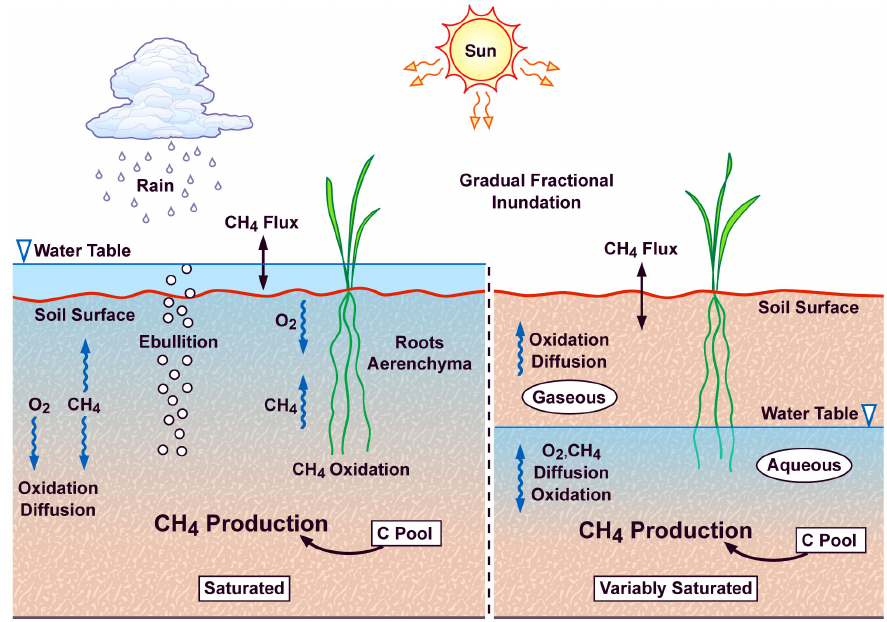
Fig. 1. Schematic representation of biological and physical processes integrated in CLM4Me that affect the net CH 4 surface flux. (left) Fully inundated portion of a CLM4 gridcell and (right) variably saturated portion of a gridcell.